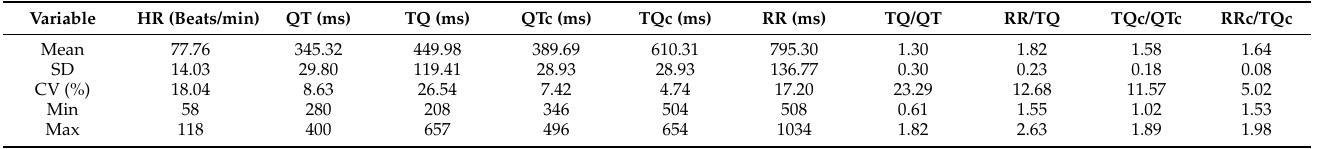
Table 2. Statistical indicators for ventricular electrical parameters in the experimental group ( n = 50).